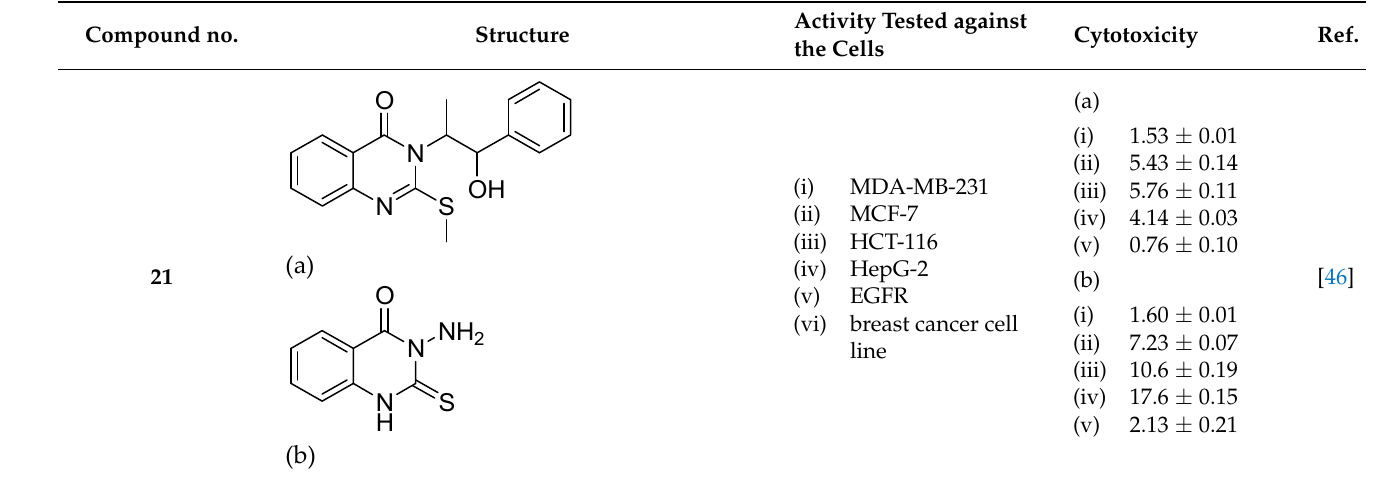
Compound no. Structure